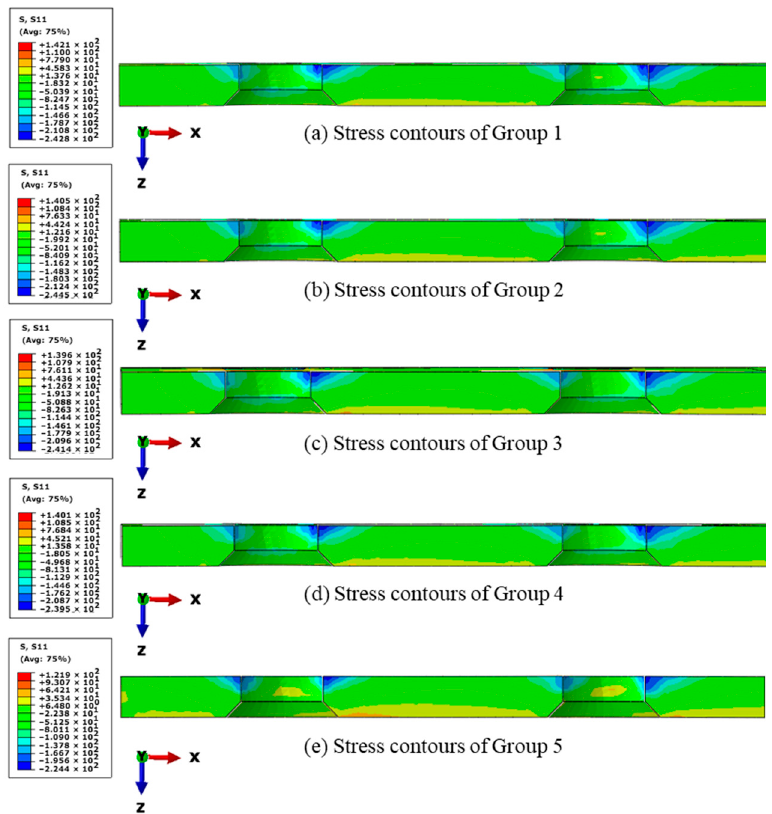
Figure 14. Stress contours of the wall sheet (Unit: MPa). ( a ) Stress contours of Group 1. ( b ) Stress contours of Group 2. ( c ) Stress contours of Group 3. ( d ) Stress contours of Group 4. ( e ) Stress contours of Group 5.